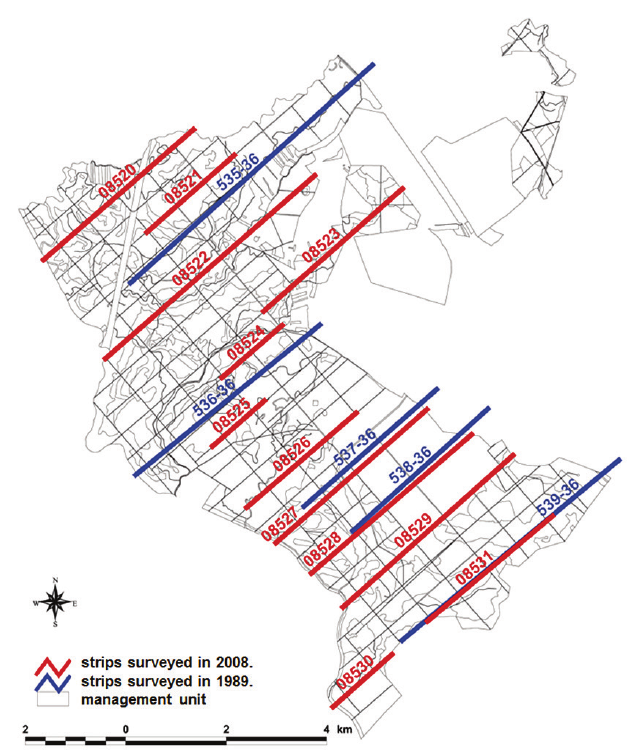
FIGURE 2. Strips surveyed in 1989 and 2008 in Josip Kozarac management